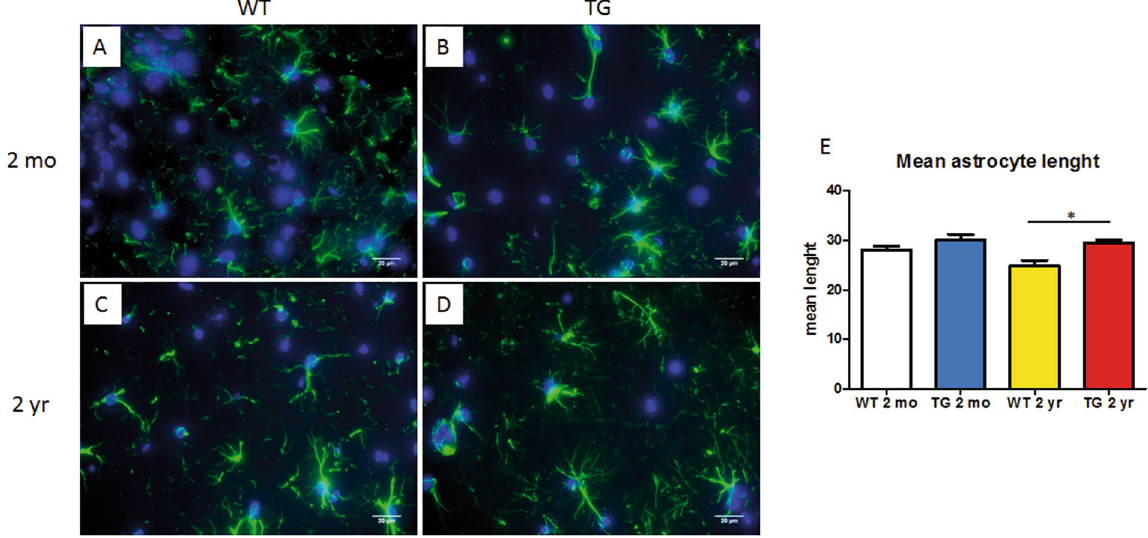
Figure 7. Calpastatin overexpression protects against brain aging. The mean astrocytic lenght decreases with aging in the CA1 area of the hippocampus. This lenght was similar in 2-months old (2 mo) animals ( A,B,E , magnification × 600). Aged CalpTG (TG) mice were less affected by this decrease than 2 years (2 yr) old WT mice ( C,D,E , * p < 0.05, n = 6/group, magnification ×